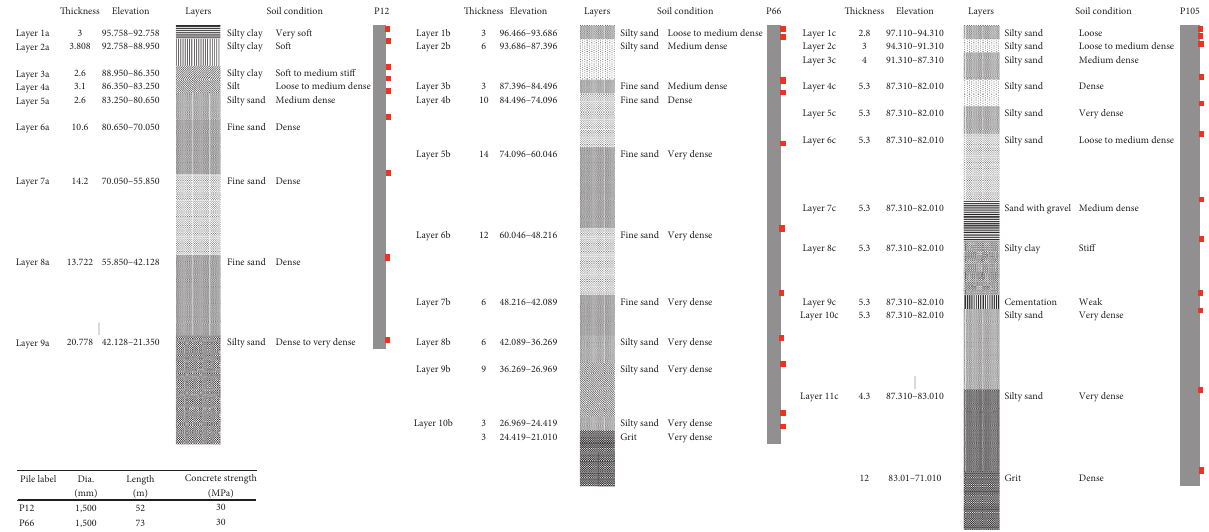
Figure 1: Subsurface conditions and tested piles (not to